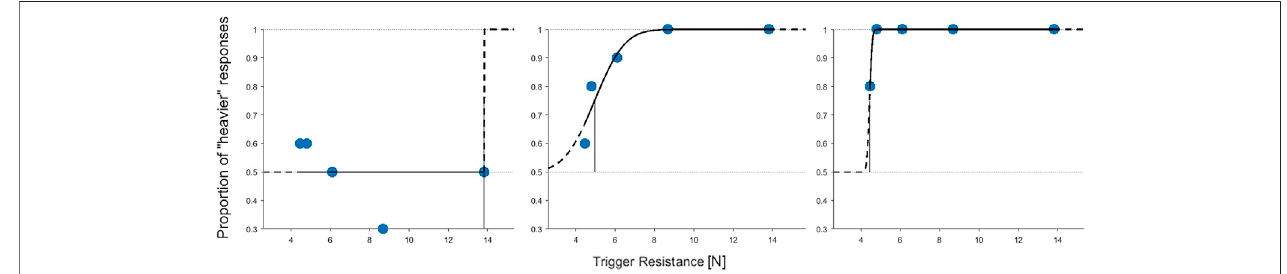
FIGURE9| PsychometricfunctionsofthreeparticipantsrepresentingthreecommonlyobservedbehavioursinouruserstudyfortheperceptionofTriggermuscle ’ s adaptive trigger resistance. (left) “ Heavier ” -responses are located closely around and below guess rate not allowing a direct conclusion for the perception of different